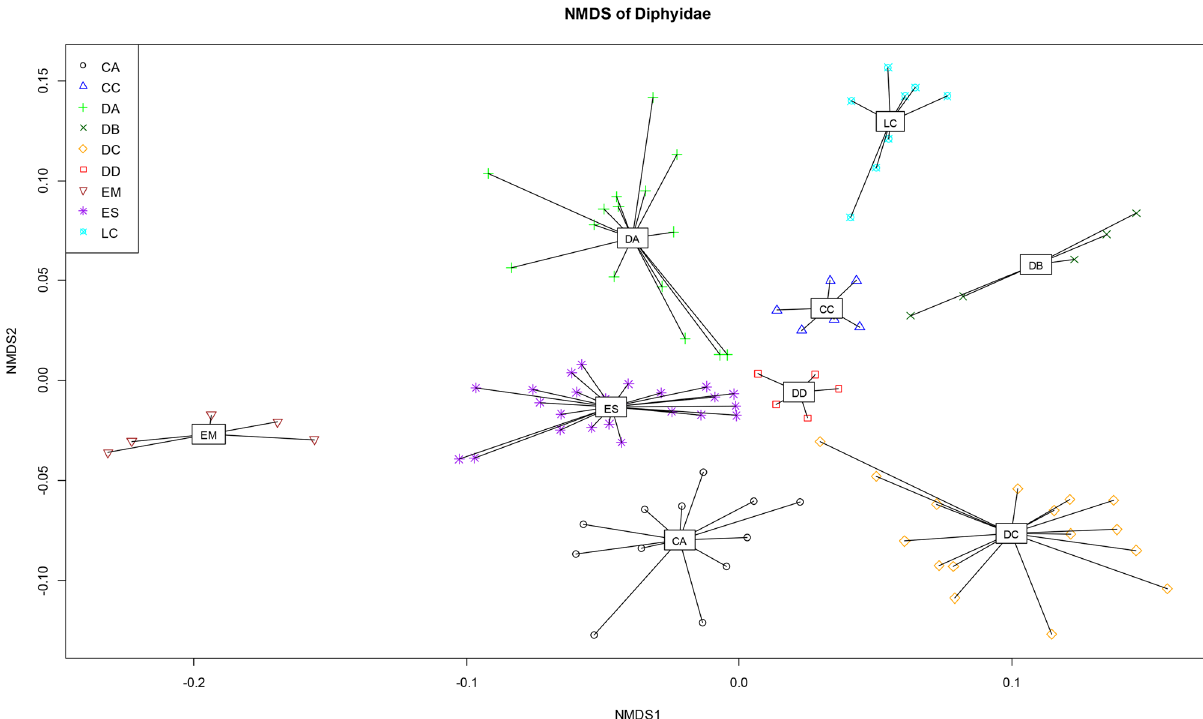
Figure 5. NMDS plot of the protein mass spectra of nine Diphyids from the Hellinger-transformed matrix (98